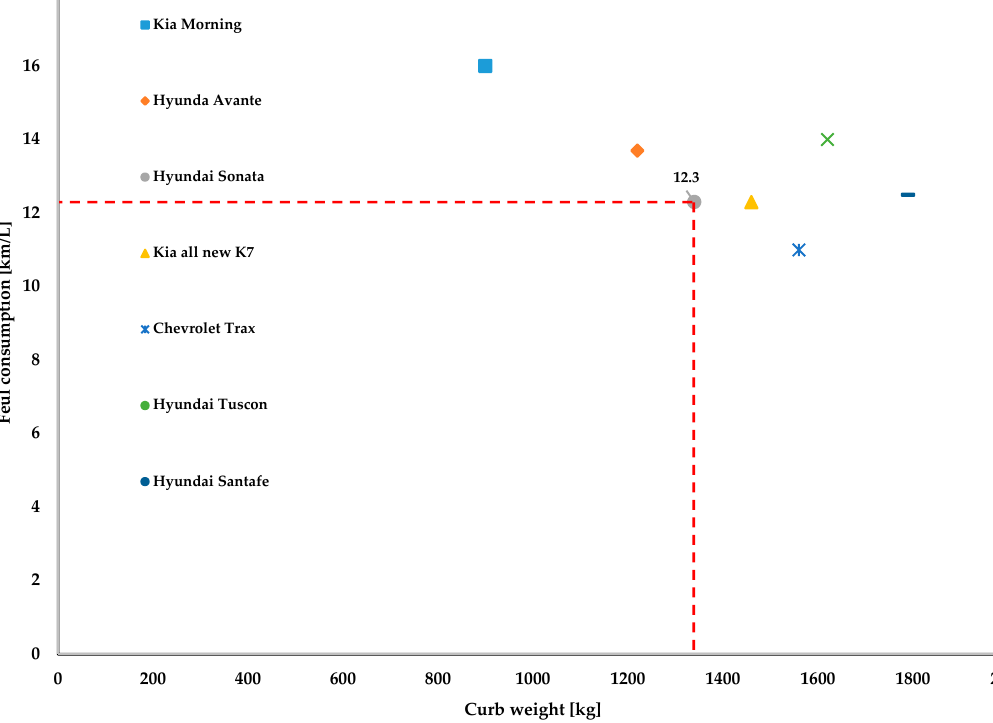
Figure 1. Correlation between fuel efficiency and vehicle curb weight of ICEV(internal combustion engine vehicle) on sale in the Republic of Korea.